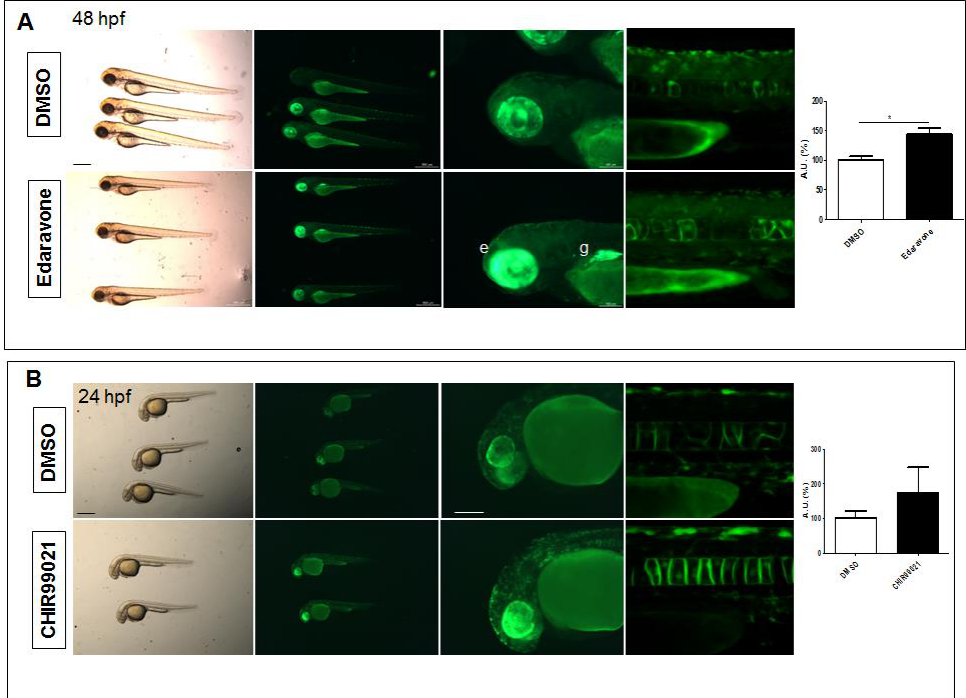
Figure 3. Pharmacological testing of Nrf2/ARE reporter fish. ( A ) Whole-mount bright field and fluorescence microscopy acquisition of 48 hpf transgenic larvae treated with DMSO or the radical scavenger Edaravone for 24 h. An evident increase in fluorescence is detected in the eye (e) and gut (g) of Edaravone-treated larvae when compared to DMSO-treated control fish. ( B ) Whole-mount bright field and fluorescence microscopy acquisition of 24 hpf transgenic larvae treated with DMSO or the GSK3 β antagonist, CHIR99021, for 16 h. Increased reporter fluorescence is observed throughout the whole larvae when compared to the DMSO-treated control fish. The magnifications of the trunk regions are confocal Z-stack acquisitions. The graphs reported on the right depict the ImageJ-based quantification of the selected trunk region of 5 independent treated fish. (* p < 0.05, t -test) All images are lateral views with anterior to the left. Scale bars in the panels with multiple fish: 500 µ m; scale bars on the panels with a single magnified larva: 100 µ m.